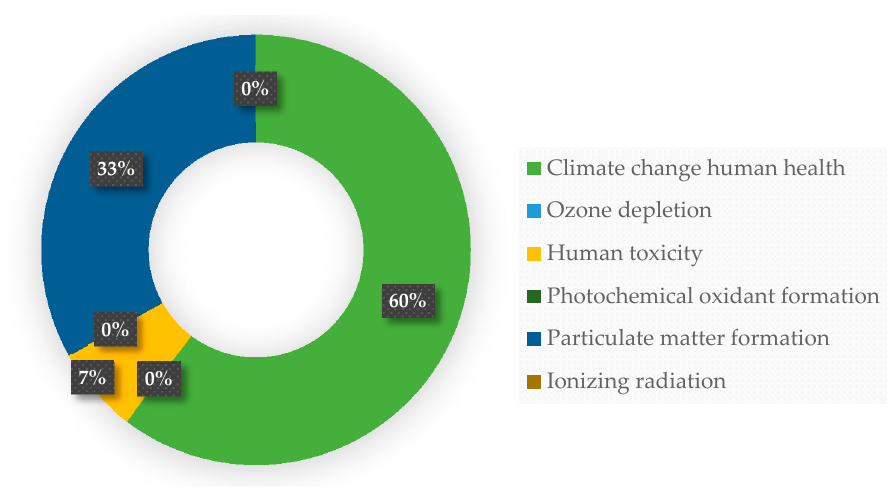
Figure 4. Contribution of each impact category to the total disability adjusted life year (DALY).